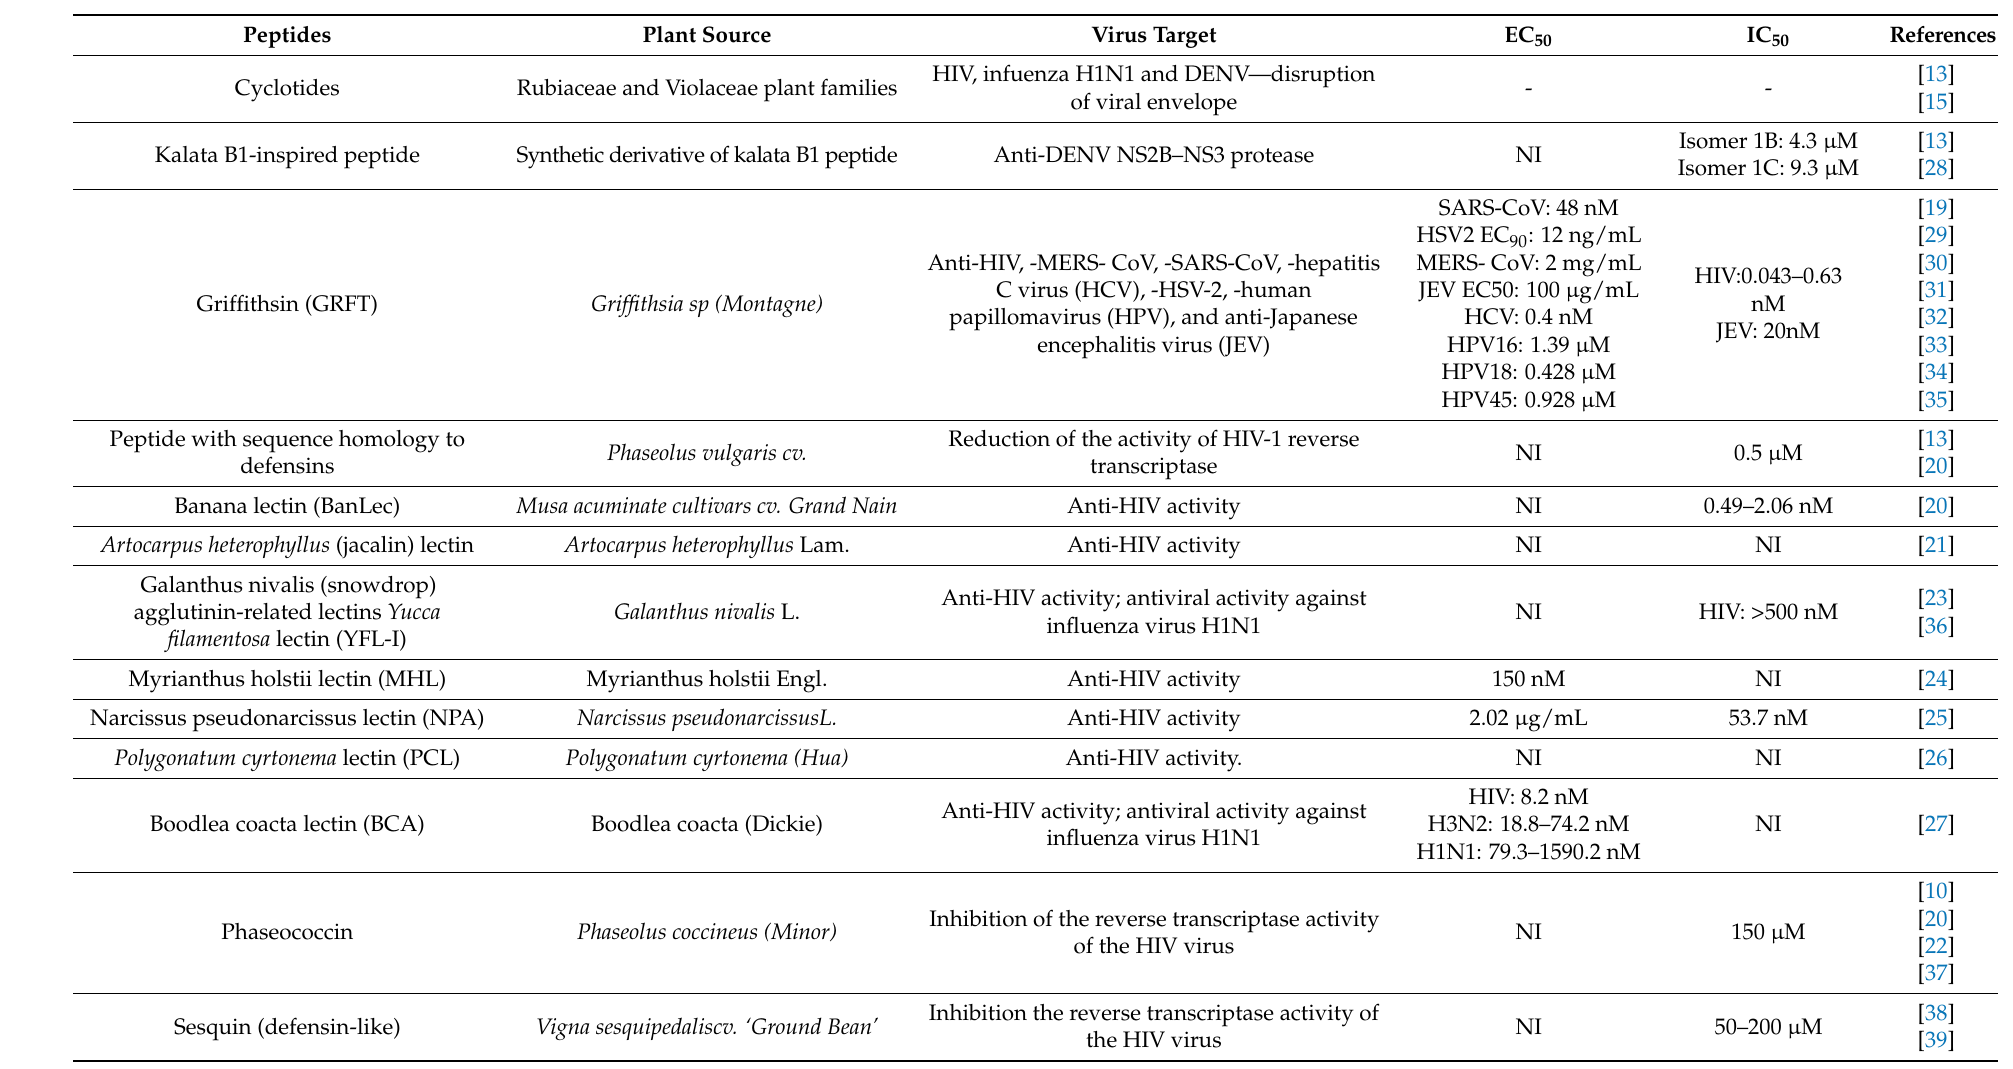
Table 1. Antiviral activities of plant